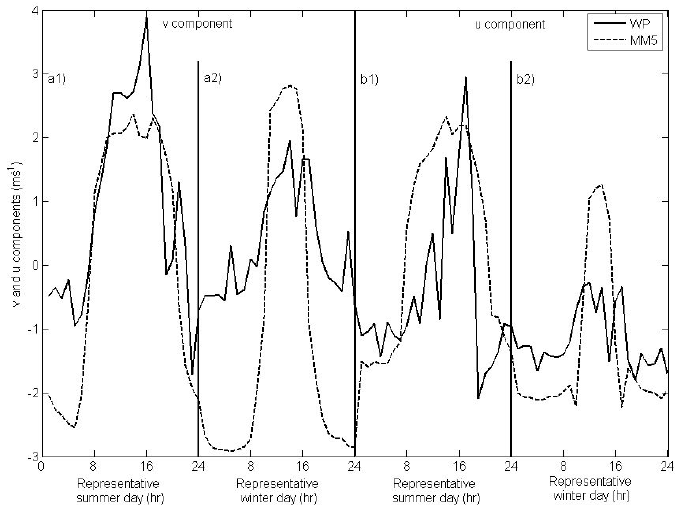
Fig. 9. Left panel: Diurnal cycle of v components, of near-surface winds, as measured by the wind profiler (solid line) and predicted by the MM5 numerical model (dashed line) for the representative summer (a1) and winter (a2) days. Right panel: Diurnal cycle of u components, of near-surface winds, as measured by the wind profiler (solid line) and predicted by MM5 (dashed line) for the representative summer (b1) and winter (b2) days.